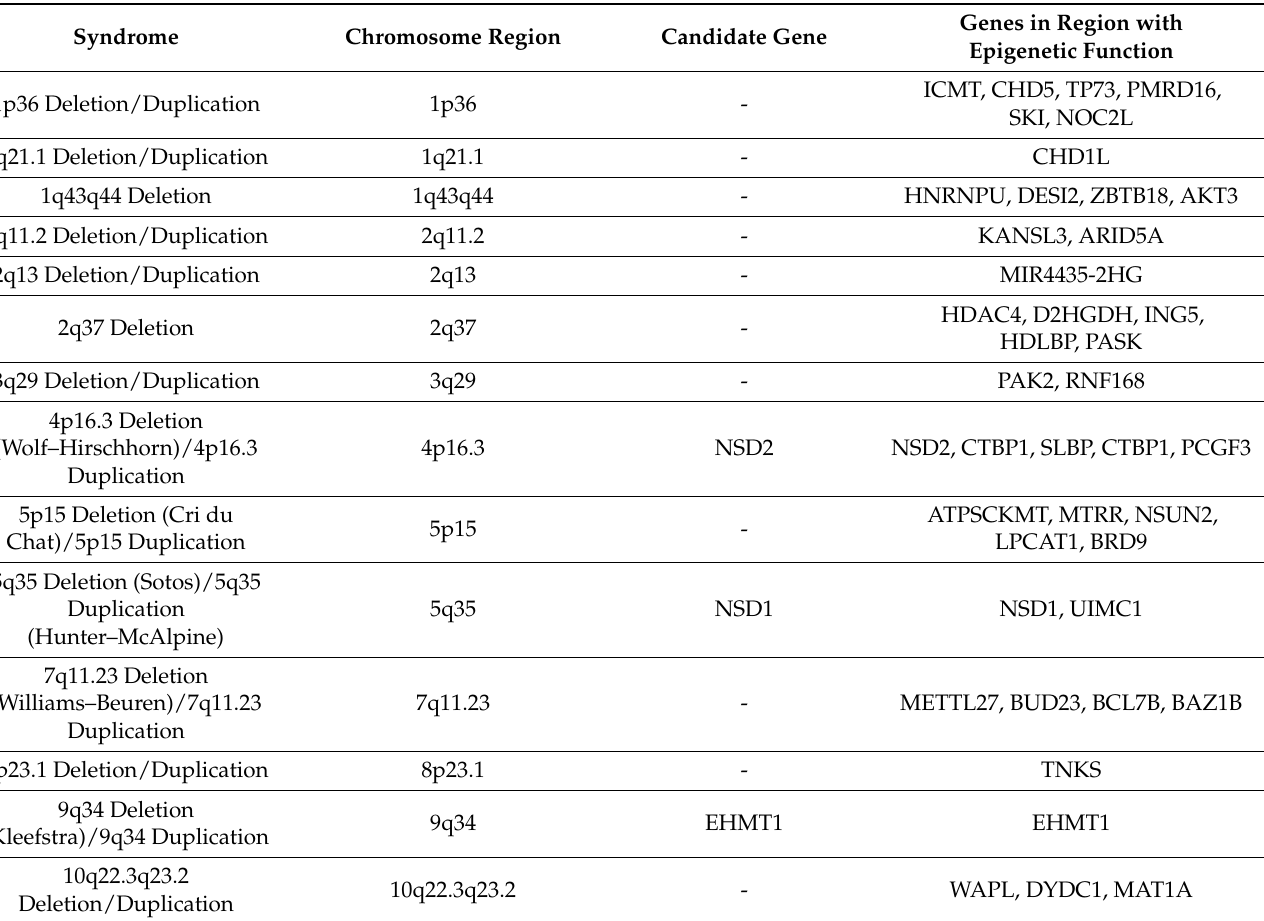
Table 2. Common CNV disorders including the candidate genes involved in the clinical phenotype (where applicable), and genes contained within with reported epigenetic machinery